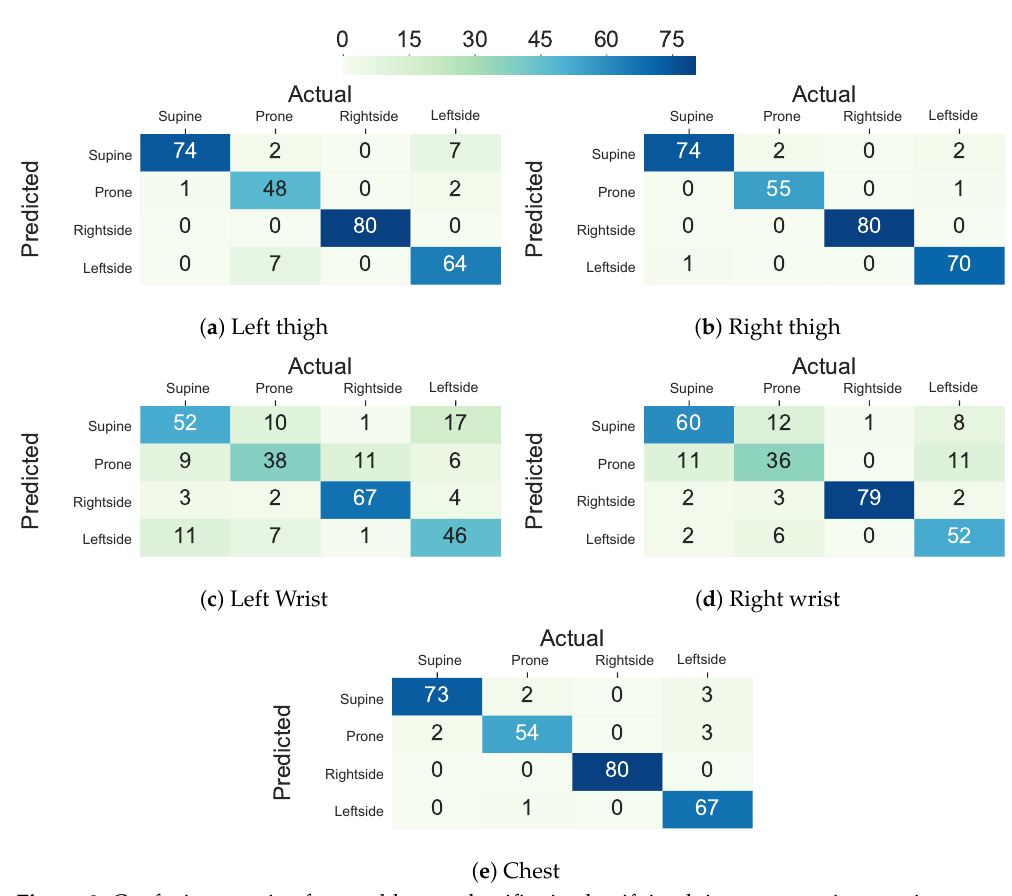
Figure 9. Confusion matrix of ensemble tree classifier in classifying lying postures into supine, prone, and left side for the thighs, ankles, arms, and wrists